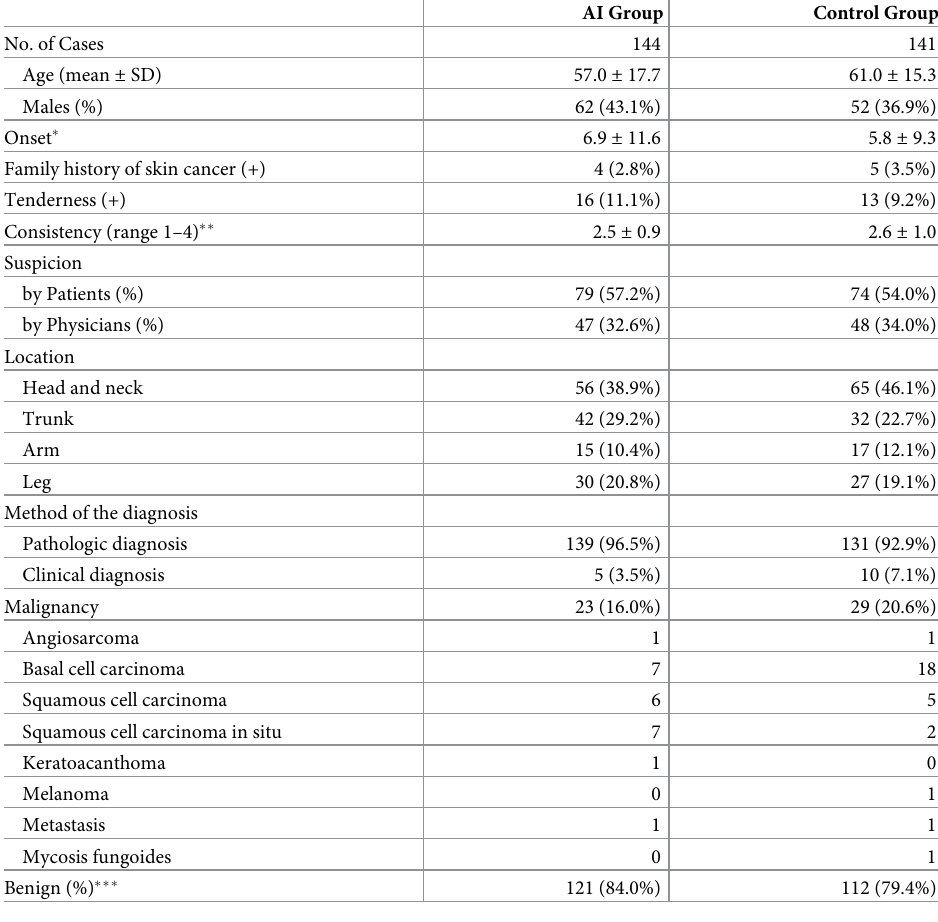
Table 1. Dataset and demographic